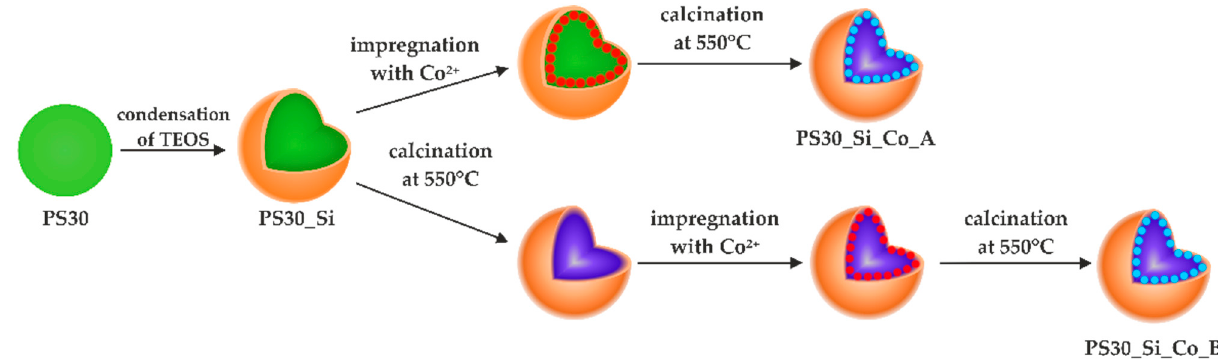
Scheme 1. Synthesis of Co 3 O 4 @SiO 2 composites using spherical poly(styrene- co -acrylic acid)